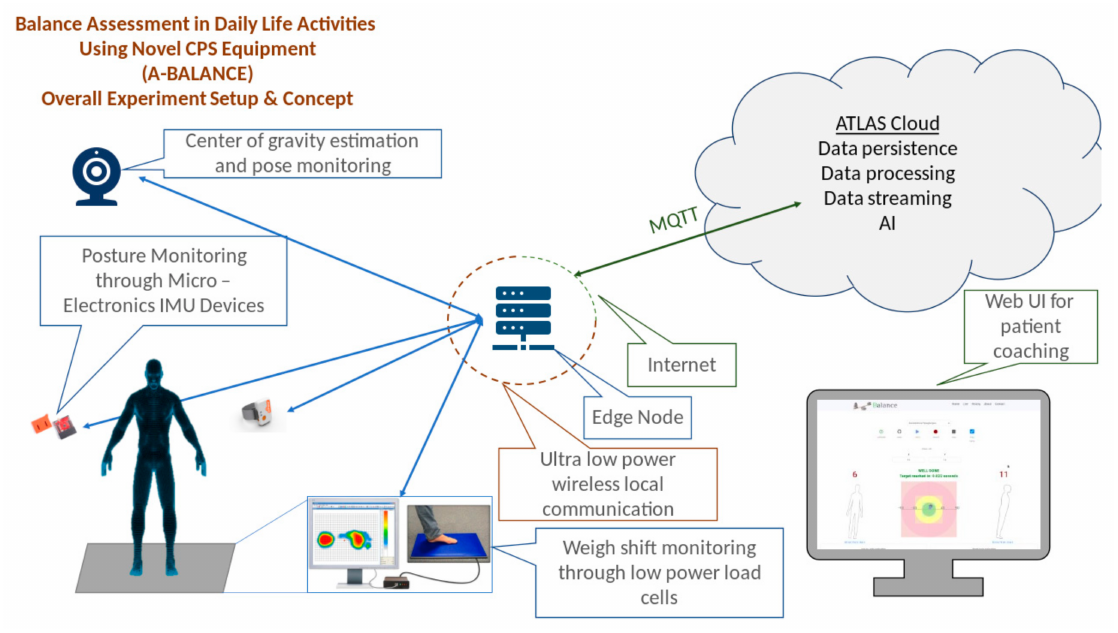
Figure 2. A-Balance